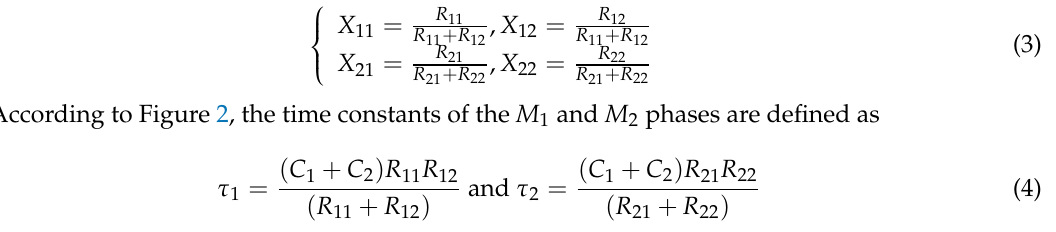
Figure 2. Equivalent circuit of unbalanced bridge with GC. ( a ) The circuit of M 1 phase. ( b ) The circuit of M 2 phase. ( c ) The equivalent circuit of M 1 phase. ( d ) The equivalent circuit of M 2 phase. The following parameters are